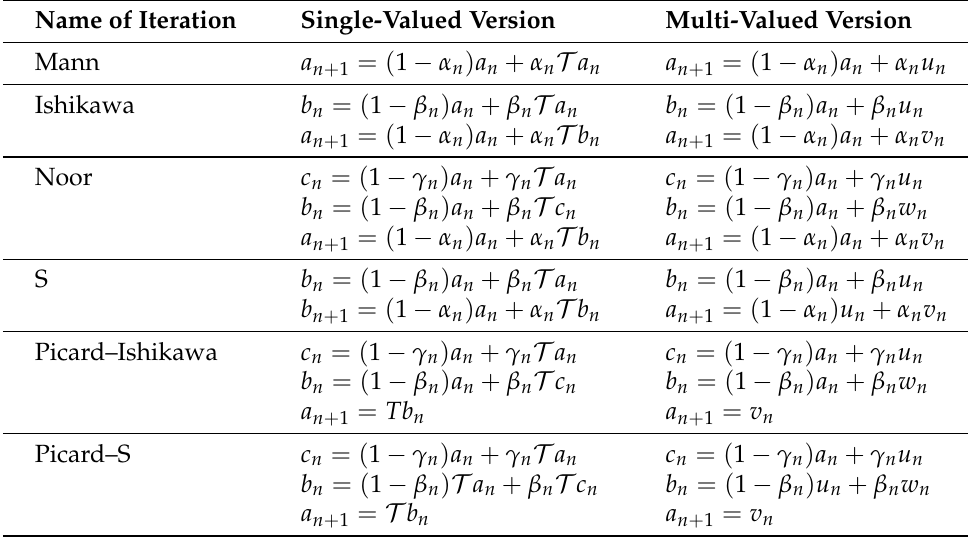
Table 1. Some well-known schemes along with their multi-valued